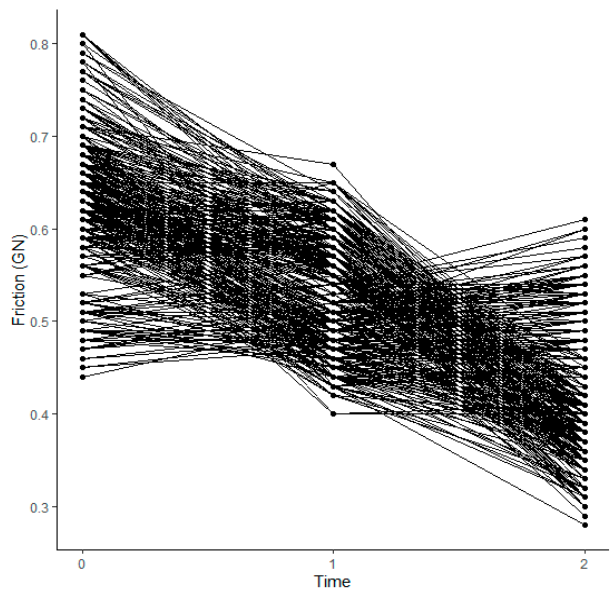
Figure 4. Observed friction values versus time for some pavement sections.